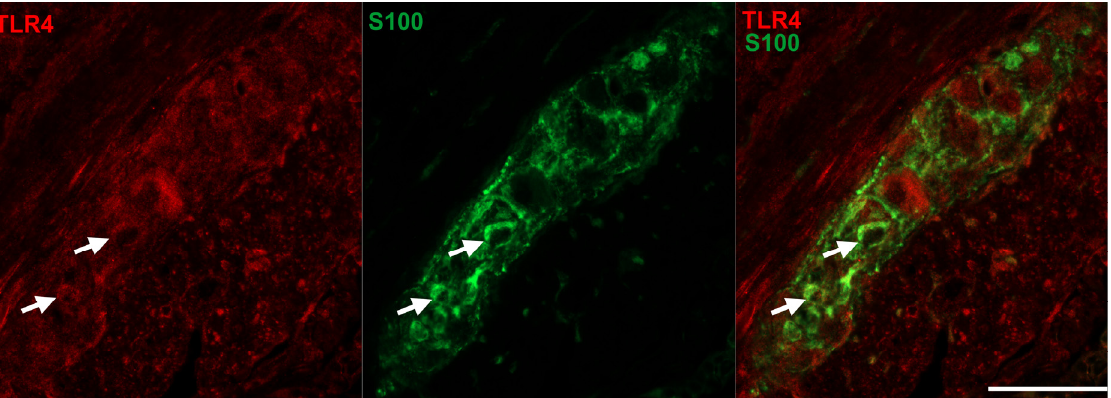
Figure 5. Representative fluorescent micrographs of a paraffin section from diabetic duodenum showing the myenteric plexus after TLR4-S100 double-labelling immunohistochemistry. S100 was applied to label enteric glial cells. Arrows—enteric glia cells, scale bars: 10 µm.